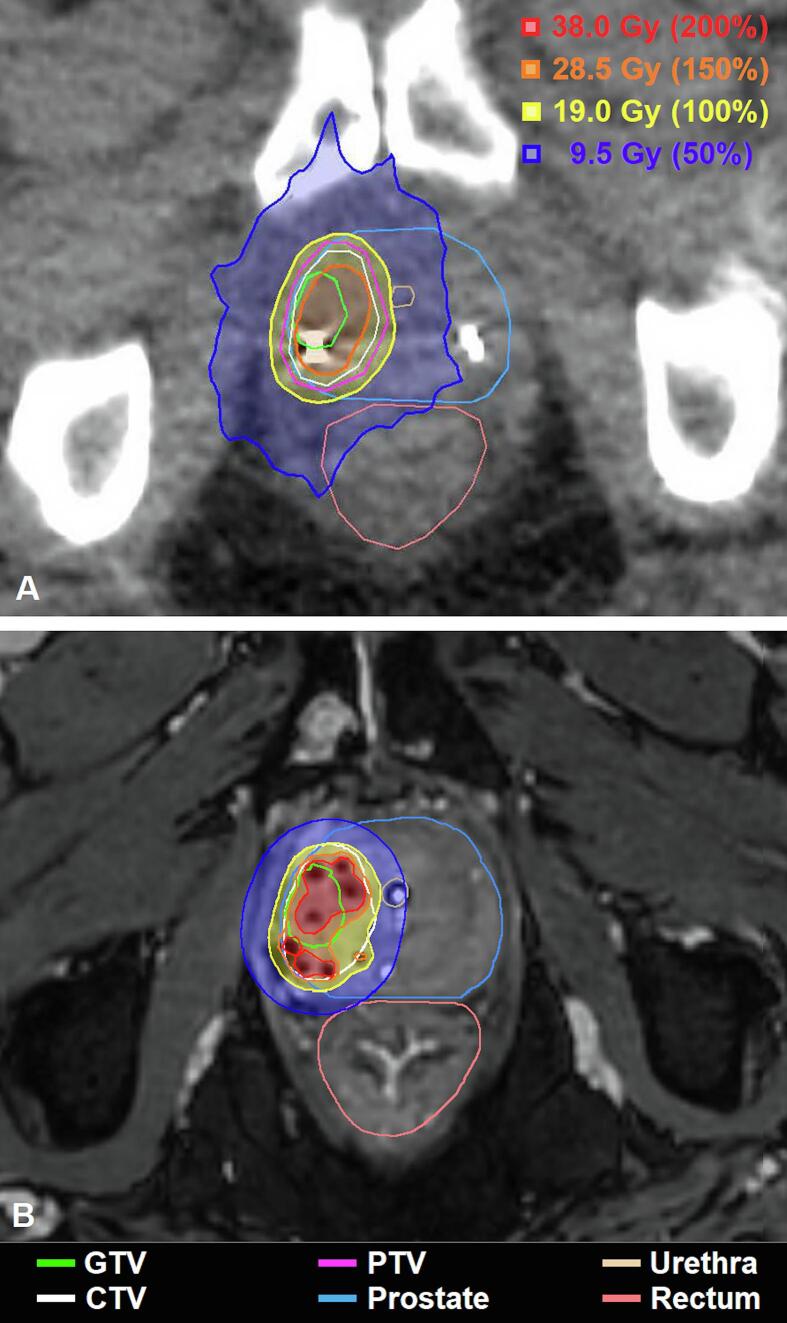
Example of dose distributions (with 50%, 100%, 150%, and 200% isodose-lines) in simulated MR-Linac plan (A) and clinically delivered FS-HDR-BT plan (B).